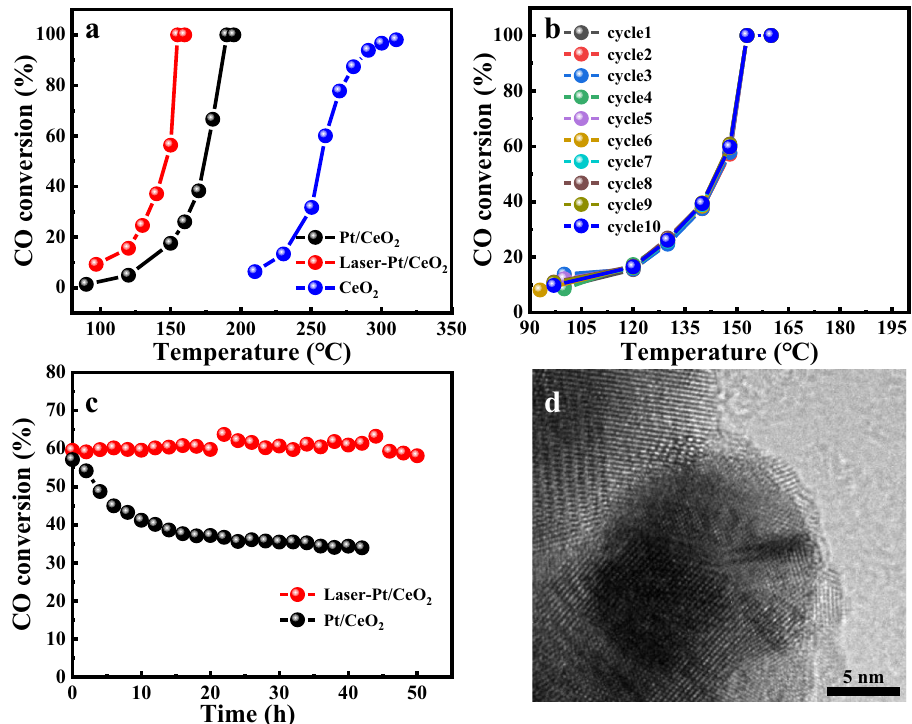
Fig. 6 Evaluation of Pt/CeO 2 nanocatalysts in CO oxidation. a CO oxidation curves of laser-irradiated Pt/CeO 2 catalyst and the reference fresh Pt/CeO 2 catalyst. b Conversion of CO from 90 to 200 °C with 1st – 10th cycles on laser-Pt/CeO 2 catalyst. c On-stream reaction of laser-irradiated Pt/CeO 2 and Pt/ CeO 2 at 150 °C (space velocity: laser-irradiated Pt/CeO 2 60,000mL g − 1 h − 1 , Pt/CeO 2 20,000mL g − 1 h − 1 ). d HRTEM image of laser-irradiated Pt/CeO 2 after CO emission control reaction at 150 °C for 50